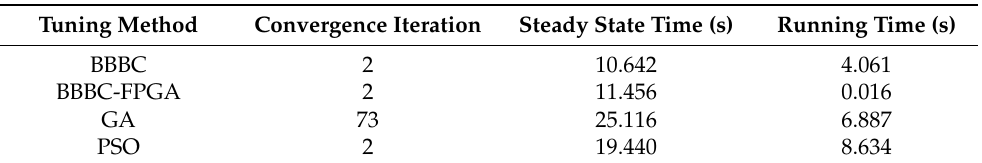
Table 5. Objective function convergence details (iterations and execution time) for all four optimization methods